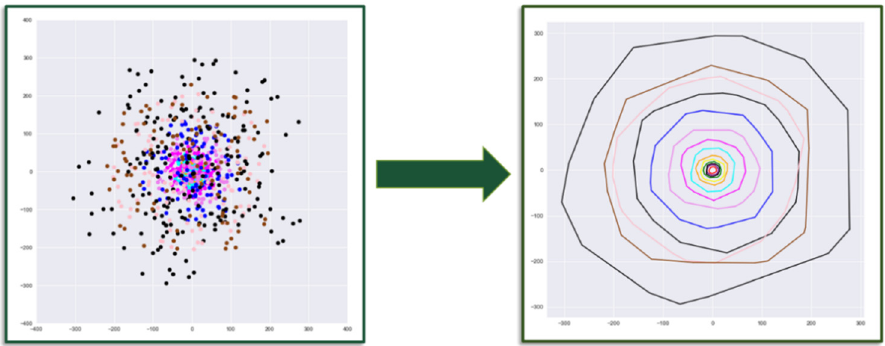
Figure 4. Aligning and registering hulls / clouds into a common spatial reference frame.